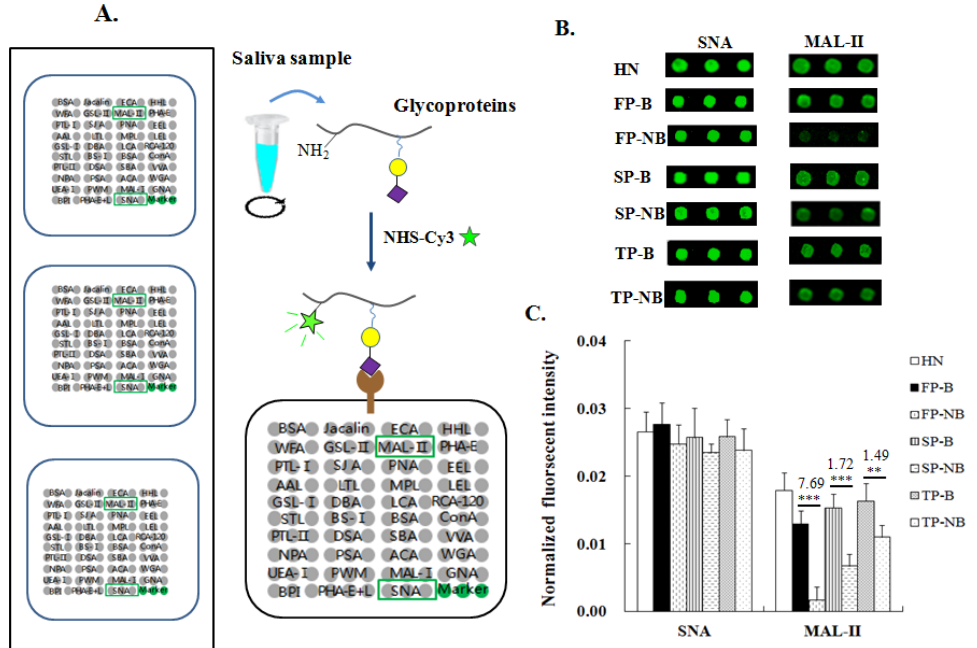
Figure 1. Comparison of the terminal α 2-3/6-linked Sia expression level on salivary proteins of postpartum women with and without breastfeeding. ( A ) The label of saliva samples with Cy3 fluorescent dye and the layout of lectin microarray. ( B ) Fluorescent images of SNA detected for α 2-6-linked Sia and MAL-II detected for α 2-3-linked Sia from the lectin microarrays used for different groups. ( C ) Normalized fluorescent intensity (NFI) of SNA and MAL-II binding to salivary proteins of different groups. FP-B: first-period of postpartum women with breastfeeding; FP-NB: first-period of postpartum women without breastfeeding; SP-B: second-period of postpartum women with breastfeeding; SP-NB: second-period of postpartum women without breastfeeding; TP-B: third-period of postpartum women with breastfeeding; TP-NB: third-period of post- partum women without breastfeeding. Each sample was applied to three repeated slides, the standard deviation (SD) of NFIs for each lectin from all the repeated blocks was calculated. Data are shown as mean ± SD, Statistical significance between two different groups was analyzed by Student’s t -test and indicated by the p -value. ** p < 0.01; *** p < 0.001.